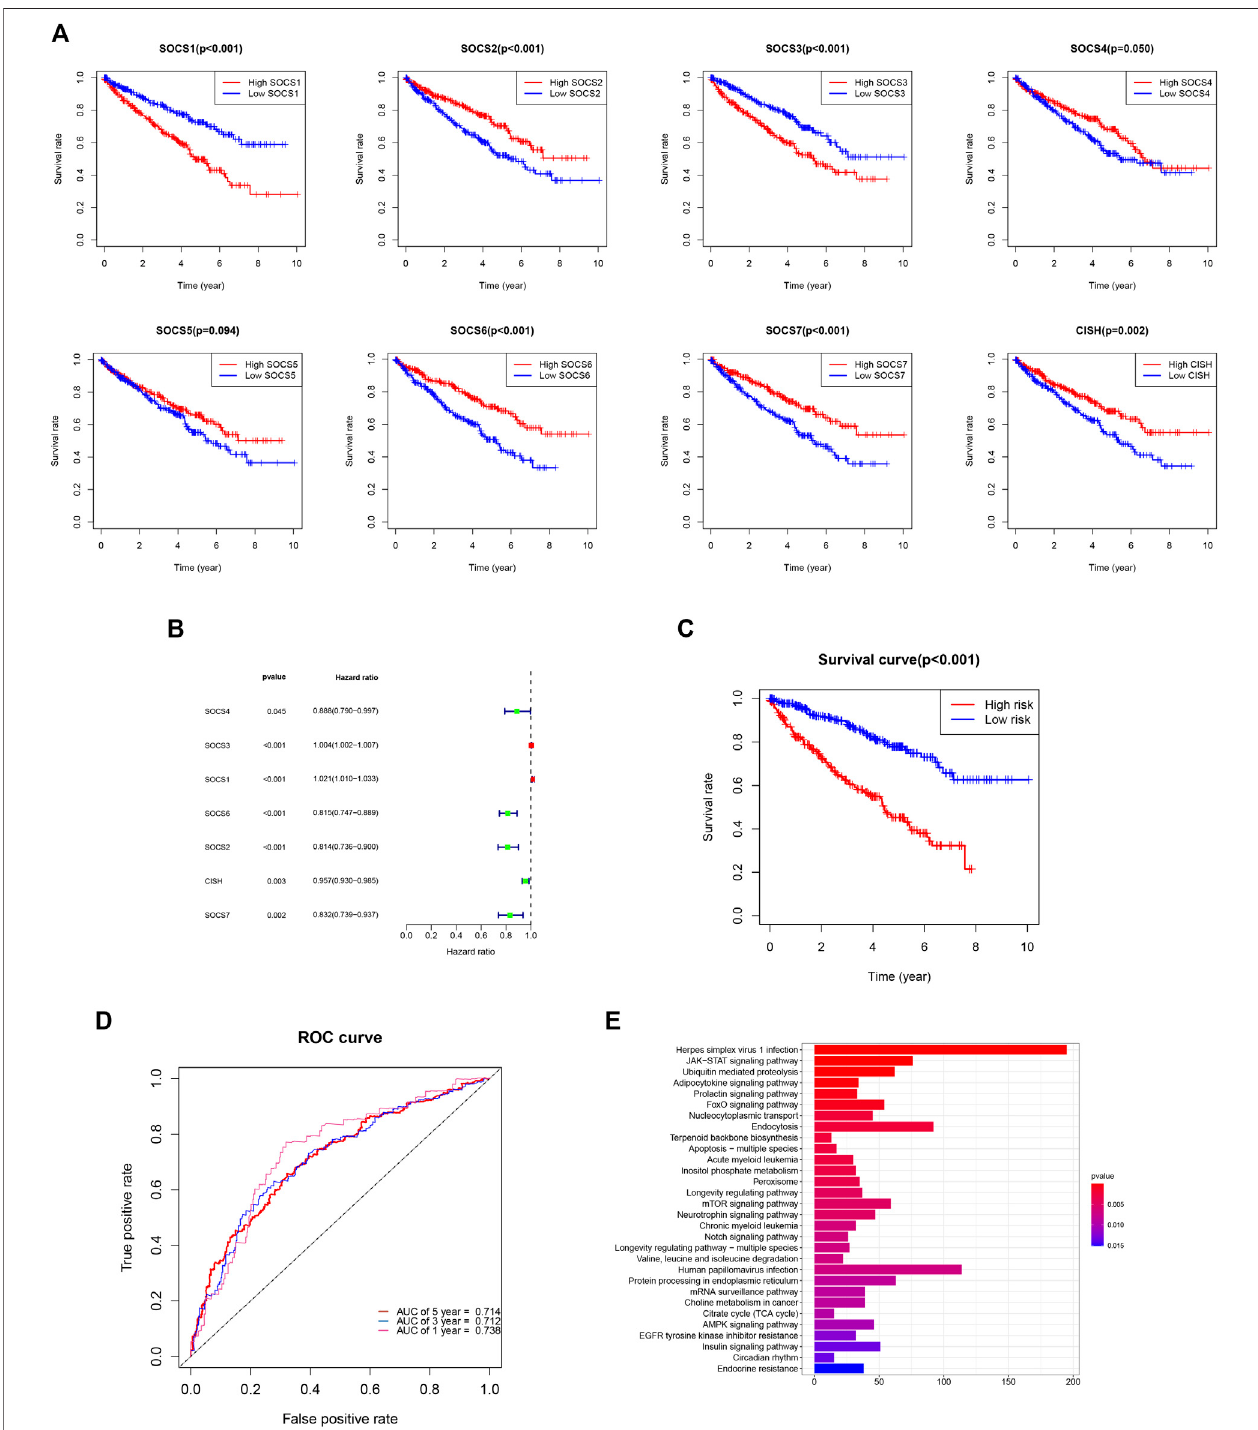
FIGURE7|(A) Prognostic valueofSOCS family membersinoverall survivalcurve. (B) Hazard ratioofSOCS family membersinunivariate Coxregressionanalysis. (C) SurvivalanalysisdemonstratedKIRCpatientsinhigh-riskgrouphadshorteroverallsurvivalthanthoseinlow-riskgroup. (D) ROCcurvesfor1-,3-,and5-yearsurvival prediction. (E) The results of KEGG pathway enrichment analysis.